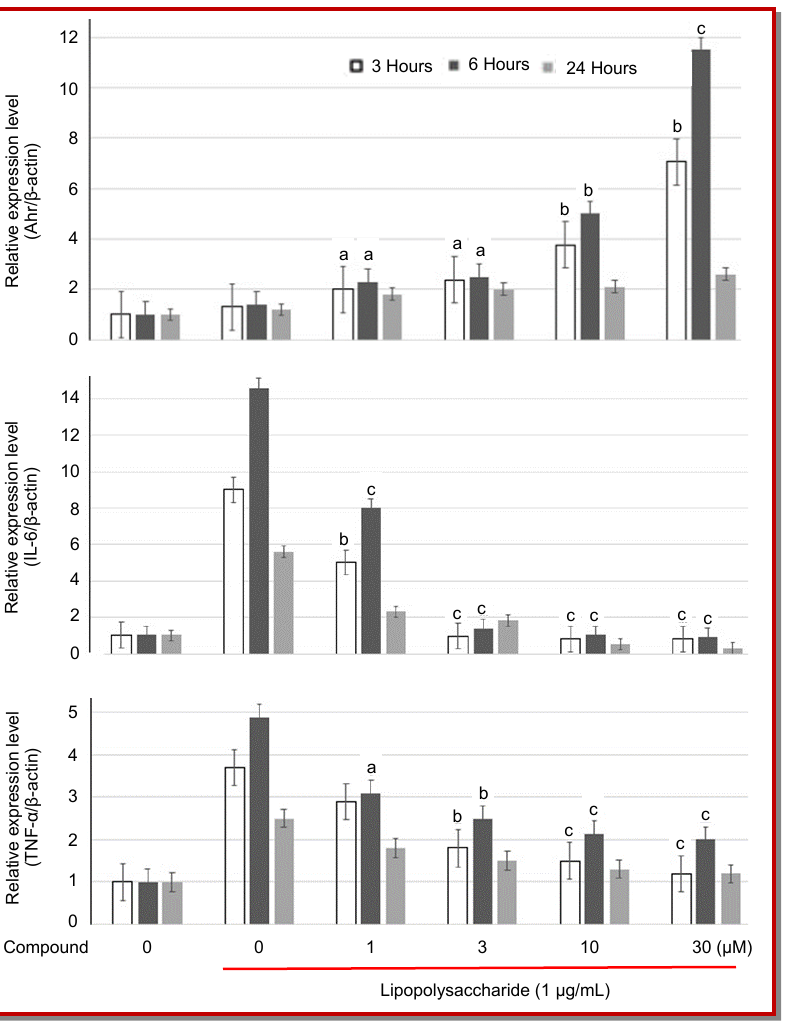
Figure 2: Effect of 9-hydroxycanthin-6-one isolated from the hairy roots of E. longifolia on the expression level of Ahr, IL-6, TNF - α in Raw 264.7 cells treated with lipopolysaccharide. RT-qPCR was utilized to measure the expression level. The mean ± SD data from three independent experiments is shown. a p<0.05; b p<0.01; c p<0.005 compared with lipopolysaccharide